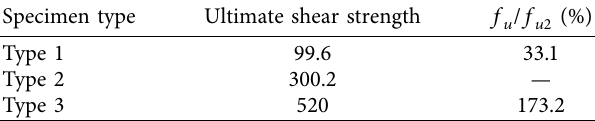
Table 3: Ultimate shear strength of specimens (kN). Specimen type